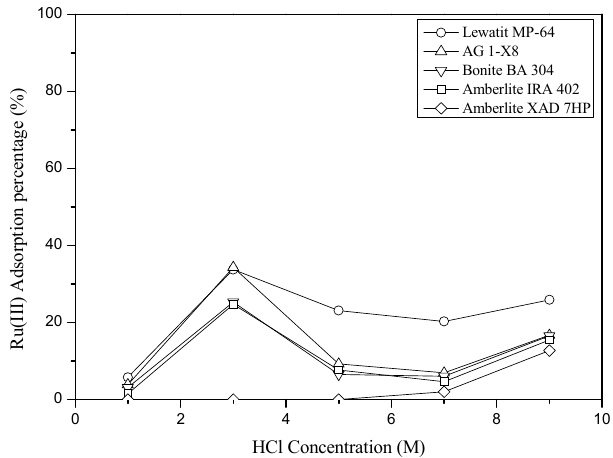
Figure 7. Effect of HCl concentration on the adsorption of Ru(III) and Co(II) onto the anion exchange resins. ([Time] = 6 h, [Resin] = 0.5 g/L, [Co(II)] = 100 mg/L and [Ru(III)] = 10 mg/L).